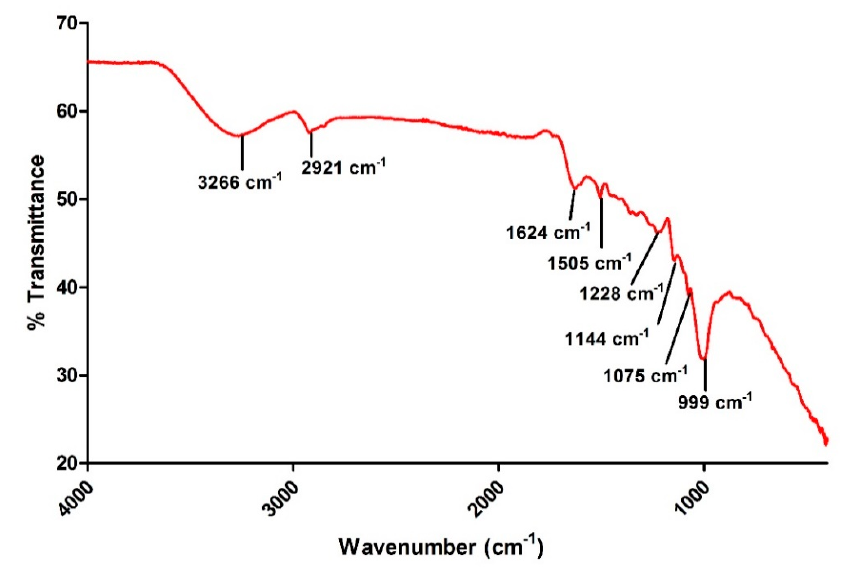
Figure 5. Fourier transform infrared spectrum of Coptidis rhizome -mediated biosynthesized silver nanoparticles.